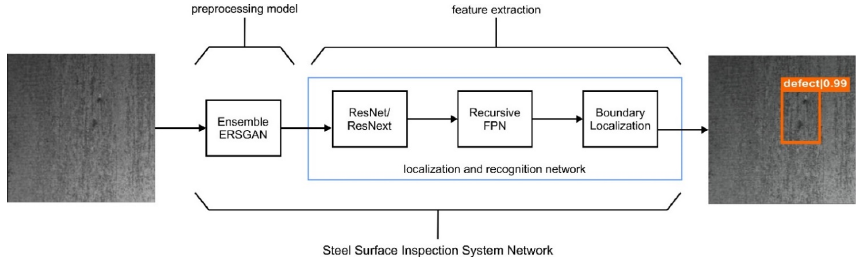
Figure 1. Flow Process detecting steel defects image. In the first stage, we proposed the preprocessing model named EnsGAN to enhance the lower resolution of input image. The next stage is feature extraction that utilizes the combination of DetectoRS, which has Recursive FPN on top of the Residual Network (ResNet) or residual aggregation network (ResNext) backbone, and side aware boundary localization in the prediction head.